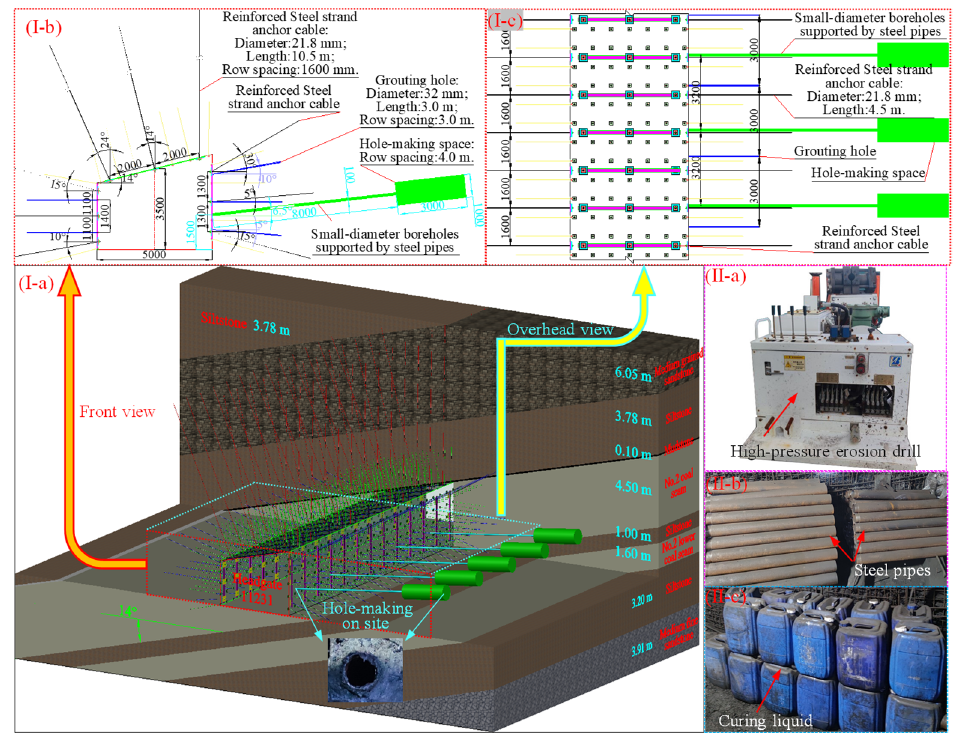
Figure 19. Schematic of cooperative control technology of external anchor–internal unloading of coal roadway surrounding rock. ( I-a ) 3D schematic diagram of roadway support; ( I-b ) Front view; ( I-c ) Top view; ( II-a ) Drilling rig; ( II-b ) Steel pipe; ( II-c ) Grouting